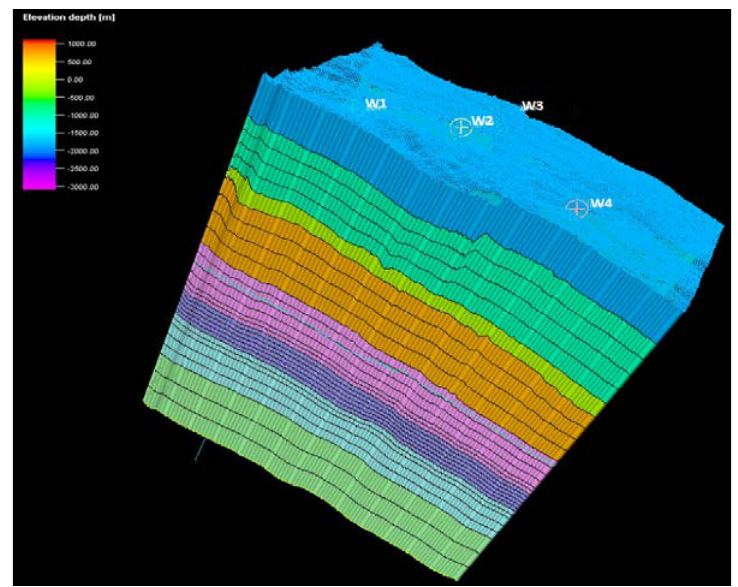
Figure 8. Generated grids for the studied field.